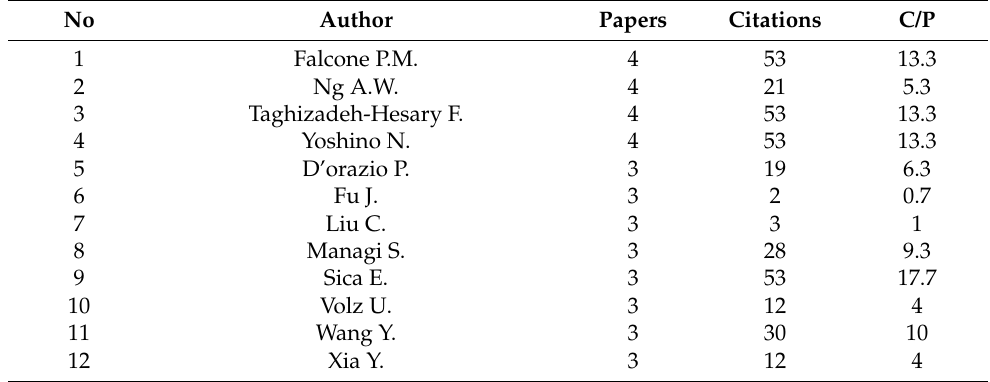
Table 5. The most productive authors in pro-environmental behavior (line 220).